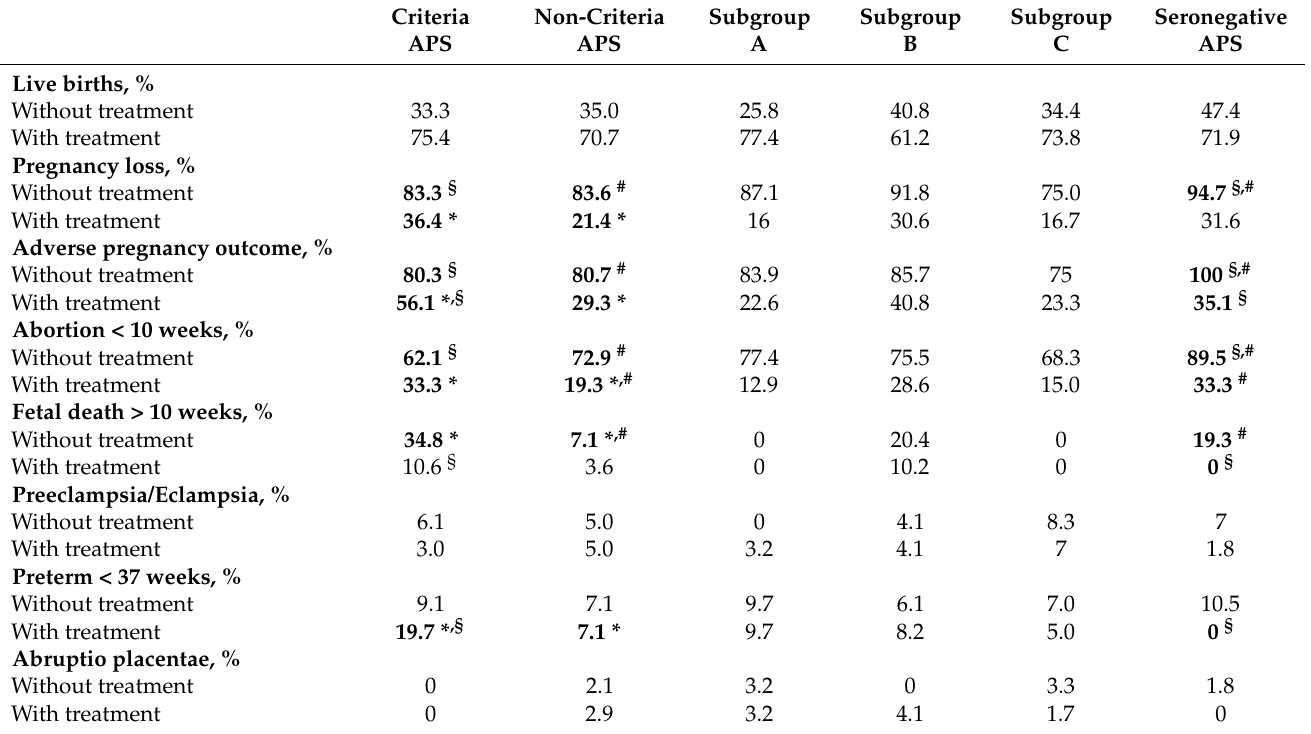
Table 7. Obstetric outcome and main obstetric complications in the different groups according to treatment. Criteria Non-Criteria Subgroup Subgroup Subgroup Seronegative APS APS A B C